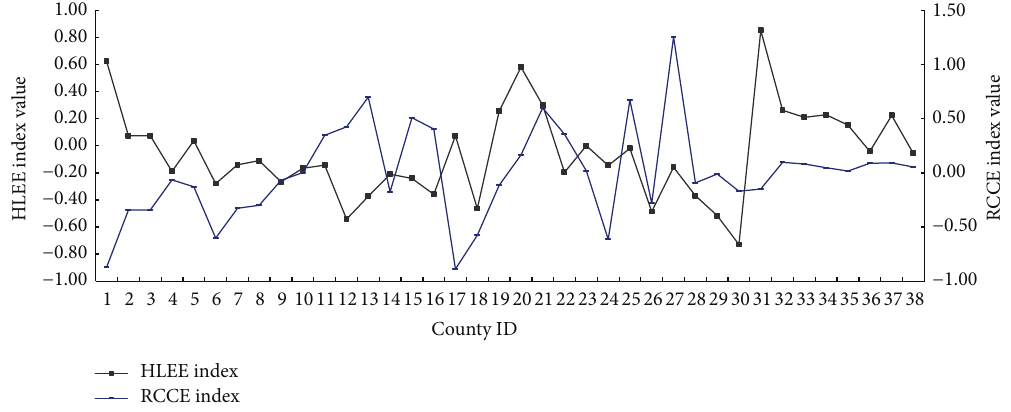
Figure 4: The curve of human living environmental evaluation (HLEE) index and resource carrying capacity (RCCE) index (county ID is the same as it in Figure